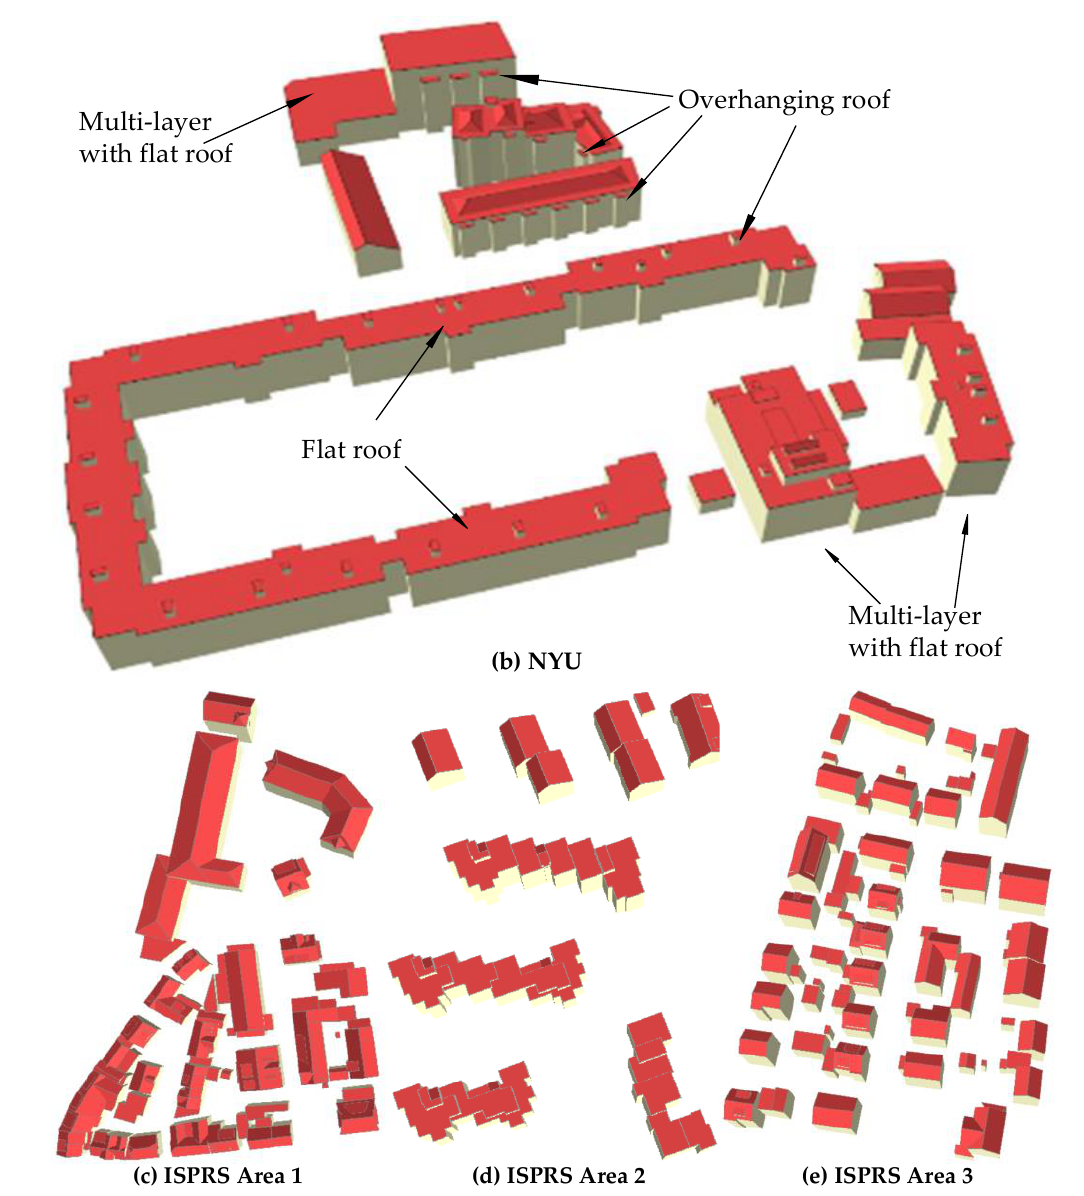
Figure 9. Reconstruction 3D models of the tested datasets.